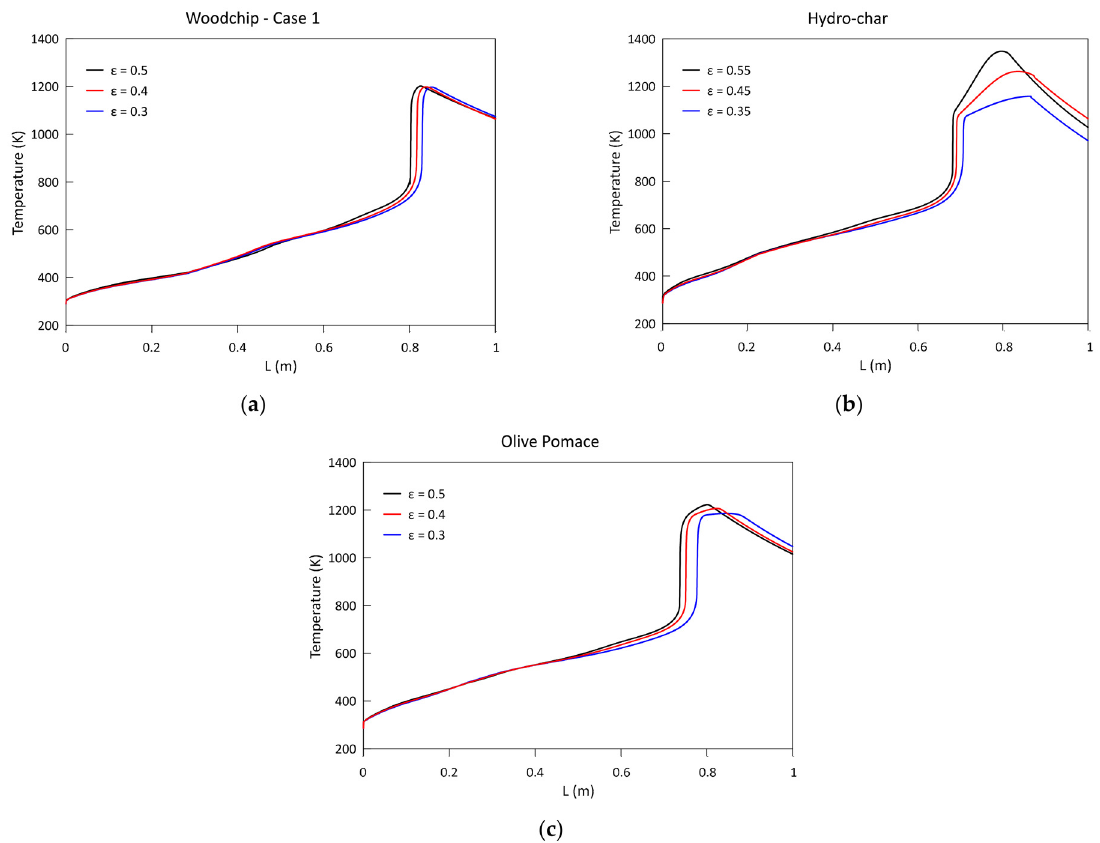
Figure 13. Temperature evolution along the reactor axis at different ε for ( a ) woodchip case 1, ( b ) hydro-char from green waste, ( c ) olive pomace.